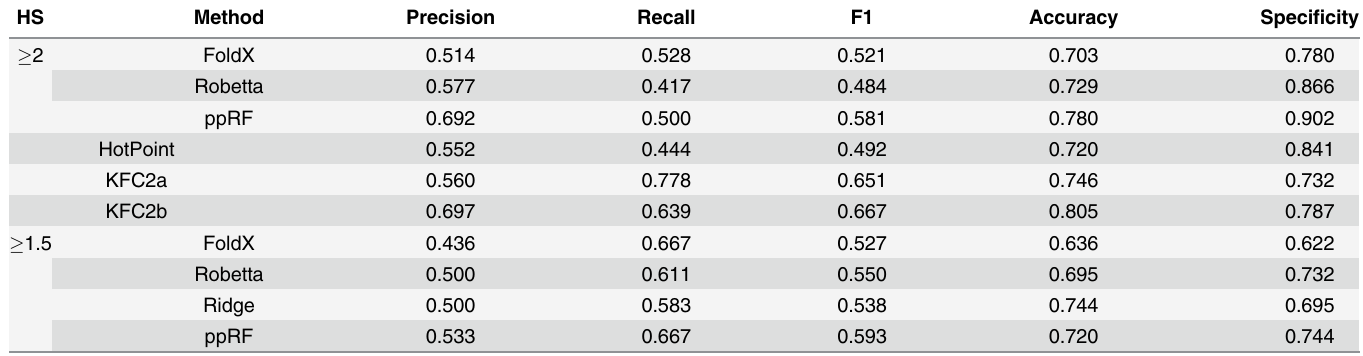
Table 3. Performance comparison between FoldX, Robetta, HotPoint, KFC2 and ppRF on the independent BID dataset, while all methods are trained using those mutations from the ASEdb dataset. FoldX, Robetta, Ridge and ppRF are able to produce numerical values of ΔΔ G p . The HS column indicates how to define a predicted binding hot spot given a predicted binding free energy ΔΔ G p : (cid:1) 2 suggests a predicted binding hot spot if its ΔΔ G p (cid:1) 2, while (cid:1) 1.5 suggests a predicted binding hot spot if its ΔΔ G p (cid:1) 1.5. ‘ Ridge ’ indicates the prediction results of Ridge regression on our feature space used for ppRF.